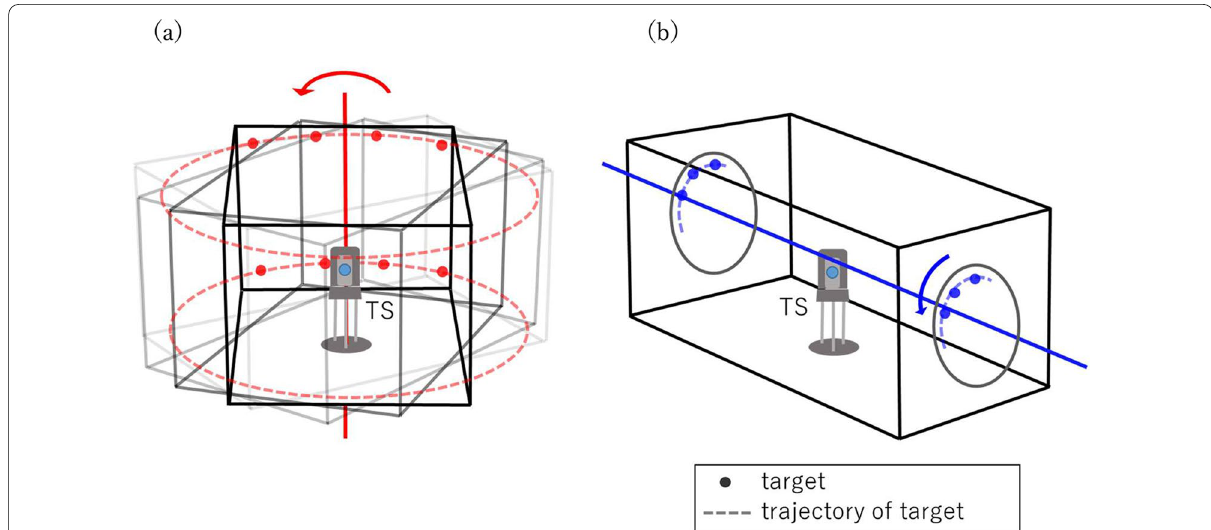
Fig. 6 Conceptual picture for estimating the axes by the inside method. Dots represent target positions observed by TS. Dotted line stands for trajectory consisting of observed target positions. a Relation between estimated Az axis and circular arcs is represented by the trajectory of target mirror; b same as (a) but for El